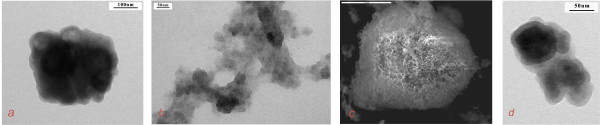
Microphotos of Ti silicates. (a) Silica obtained by base catalysis (TEM), (b) silica obtained by acid catalysis (TEM), (c) Ti0.03Si0.97O2 obtained by base catalysis (SEM), and (d) Ti0.03Si0.97O2 obtained by base catalysis (TEM).